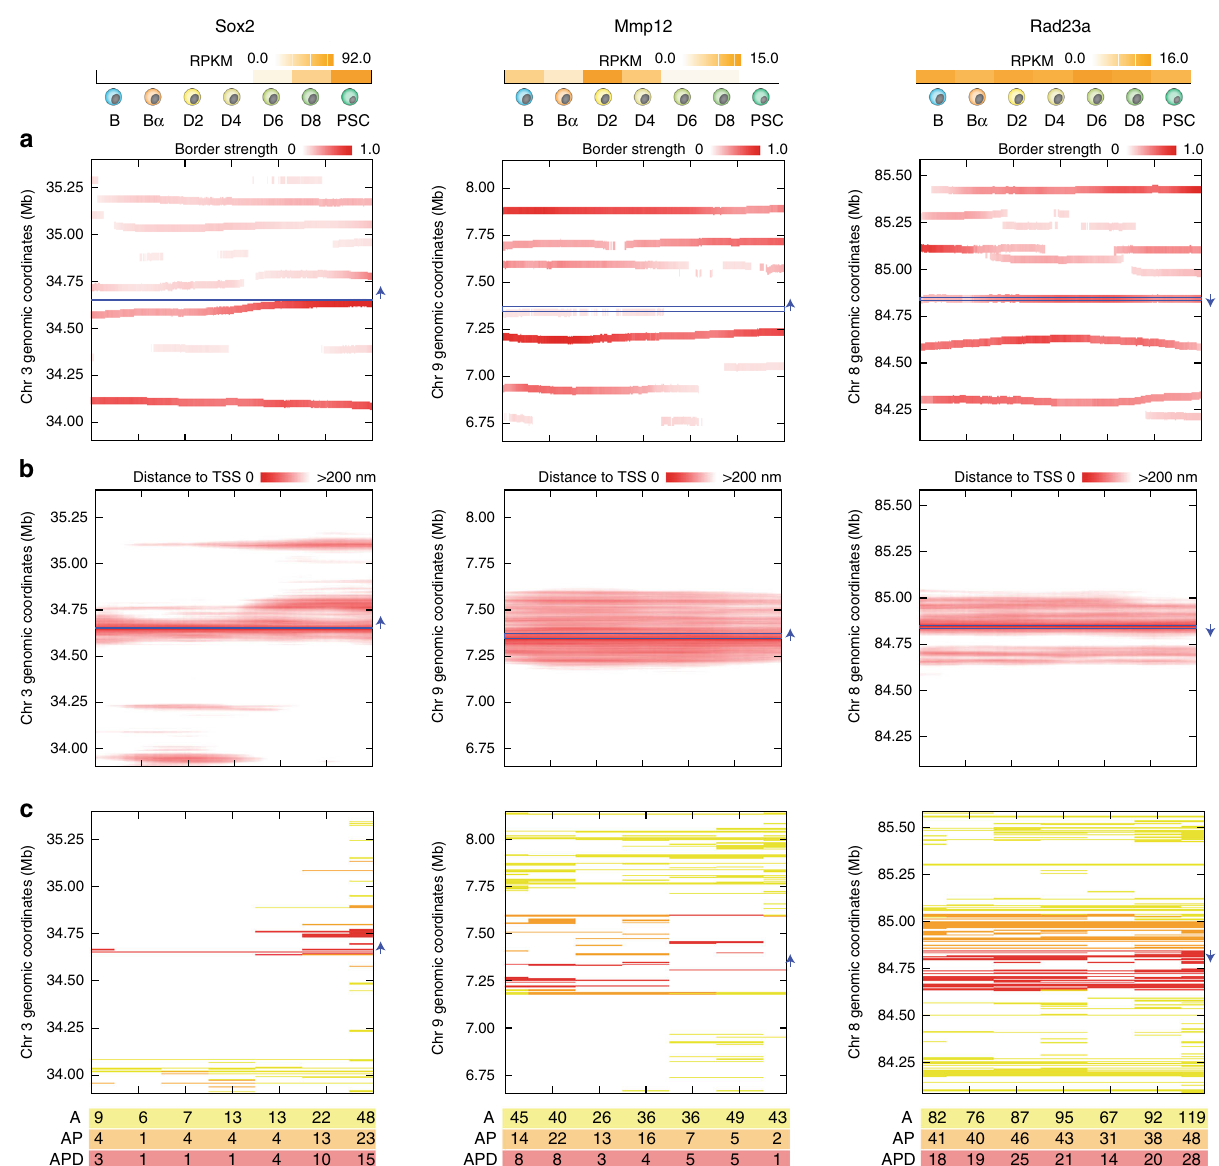
Fig. 4 Gene activity correlates with domain borders and enhancer proximity. Top of the fi gure indicates expression level (RPKM) for each of the selected loci at each reprogramming stage 35 . a Time dependent position of the domain borders as de fi ned by the insulation score analysis on the contact maps derived from the models. The position of the loci in the graph is indicated by a blue horizontal line and its transcriptional orientation is indicated by a blue arrow. b Heat maps of the distances between the TSS particle and all the other model particles as a function of time. c Particles classi fi cation into active (A, yellow), active and proximal to the TSS (AP, orange), and active, proximal and within the domain (APD, red). The bottom table shows the number of particles in each category for each reprogramming